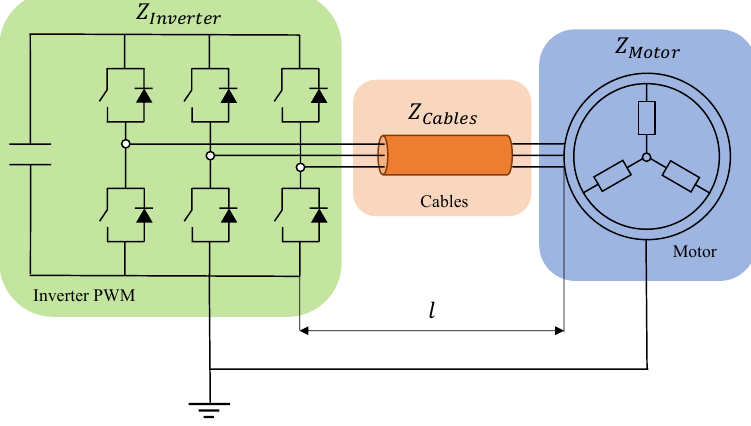
Figure 5. Schematic of a variable frequency drive highlighting the inverter, cable, and motor impedances. The reflection coefficient is defined as the ratio between the reflected wave and the incoming wave, ρ